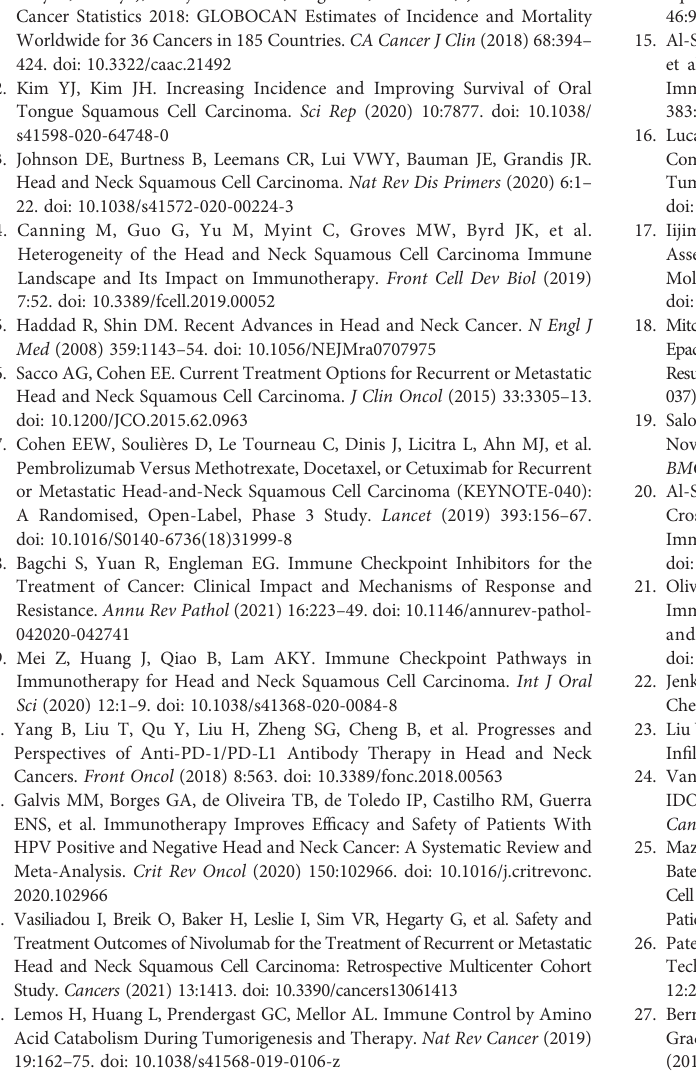
Supplementary Figure 2 | Neither nivolumab nor epacadostat affects HSC-3 viability. Fourdifferent concentrations ofnivolumab andepacadostat werescreened for their cytotoxic effect on HSC-3 cells using a CellTiter-Glo assay. Viability did not signi fi cantly (p>0.05) vary between any tested concentrations of nivolumab (A) or Supplementary Figure 3 | Semi-automated analysis of coculture chips. CoculturechipsofCD4 + andCD8 + Tcellswereimagedunderfour fl uorescent fi lters toobtainamultichannel image (A) ,withHSC-3cellsintheredchannel,CD4 + Tcells in the blue channel, apoptotic cells in the green channel, and CD8 + T cells in the orange channel. The number of cancer cells, apoptotic cancer cells, and CD4 + T cellswerecalculatedasinthethree-dyesystem.ForanalysisofthenumberofCD8 + T cells, the green channel containing apoptotic cells was removed (B) and the orange channel containing the CD8 + T cells was changed to blue and overlayed withtheredchannelonly (C) .Thesoftwarethencalculatedallpositivebluecellswith red intensity (D) and all positive blue cells with the same parameters as the CD4 + T